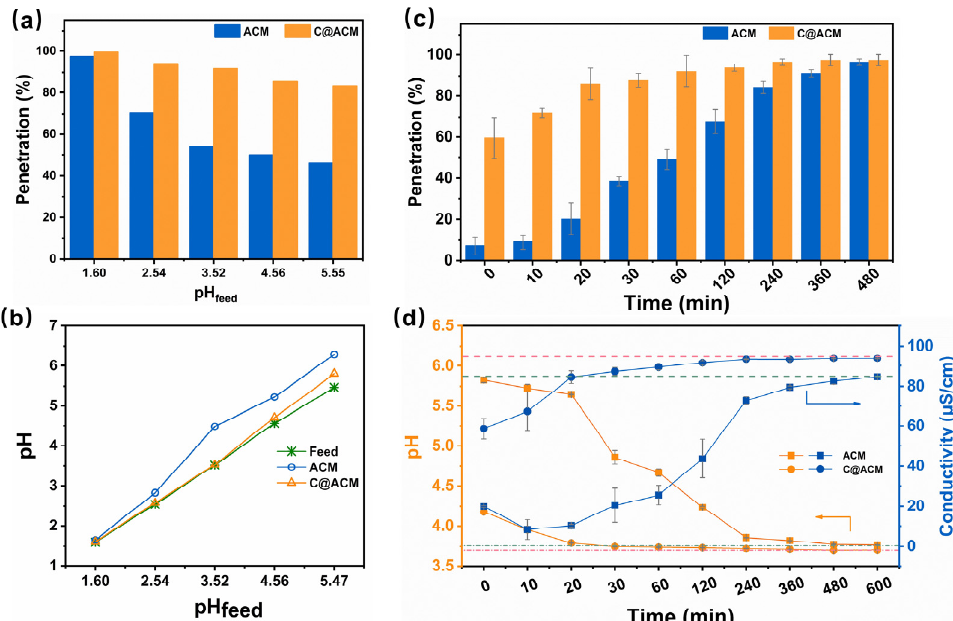
Figure 6. The permeating behavior of HCl through ACM and C@ACM: ( a ) penetration of HCl with different pH; ( b ) pH values of permeation; ( c ) Penetration of HCl; ( d ) pH values, and conductivity of permeation at different times. (The filtration experiments in a and b were ended until the volume of permeate reached 60 mL. The pH values of the feed that permeated through ACM (green dot-and-dash line) and C@ACM (pink dot and dash line) were 3.76 and 3.70, respectively. The conductivity of the feed through ACM (the green dotted line) was 84.9 μ S·cm − 1 and that through C@ACM (the pink dotted line) was 94.9 μ S·cm − 1 ).